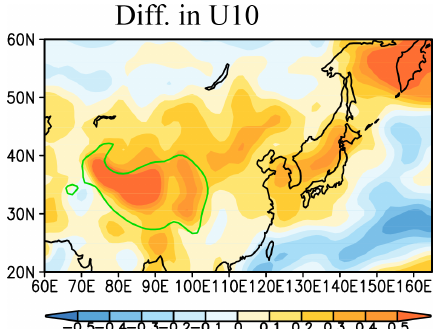
Figure 11. Spatial distribution of the MAM composite difference between the strongest and weakest TPSH years (strongest–weakest) for the model in 10m wind speed (U10, ms − 1 ). The green-contour area indicates the plateau above